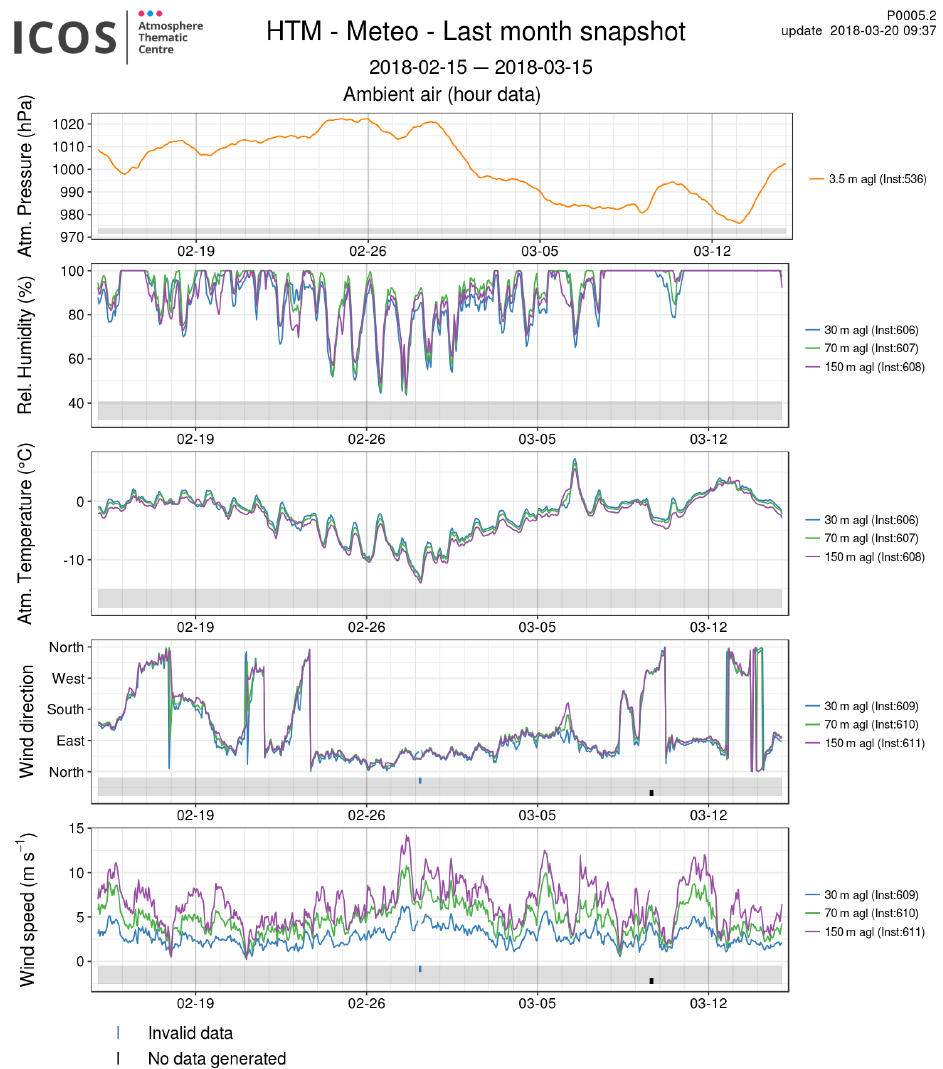
Figure 9. Meteorological parameters for 1 month at Hyltemossa station (HTM). From top to bottom: atmospheric pressure, relative humidity, atmospheric temperature, wind direction and wind speed. The data at the different levels are plotted with different